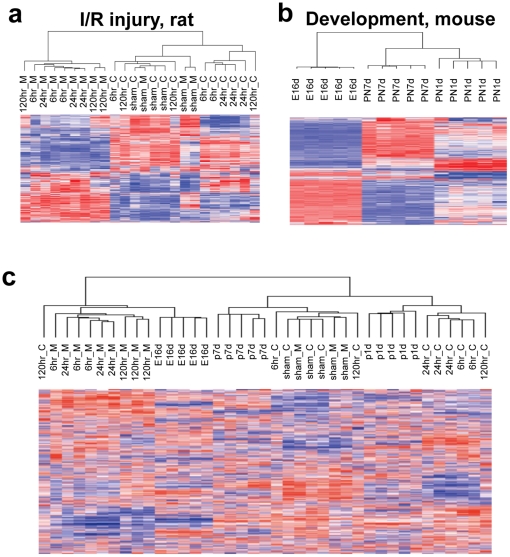
Hierarchical clustering of kidney regeneration after ischemic injury and development.
A. Hierarchical clustering of top variable 2000 genes segregates the expression profiles of renal cortex (C) and medulla (M) after ischemic injury while sham samples are also distinguished from injury-associated profiles. B. The expression profiles of fetal mouse kidney (E16d) are clearly distinguished from those of postnatal kidney (PN1d and PN7d) by hierarchical clustering. C. The rat I/R injury- and mouse development expression profiles were merged and hierarchically clustered for top variable 2000 orthologous genes.